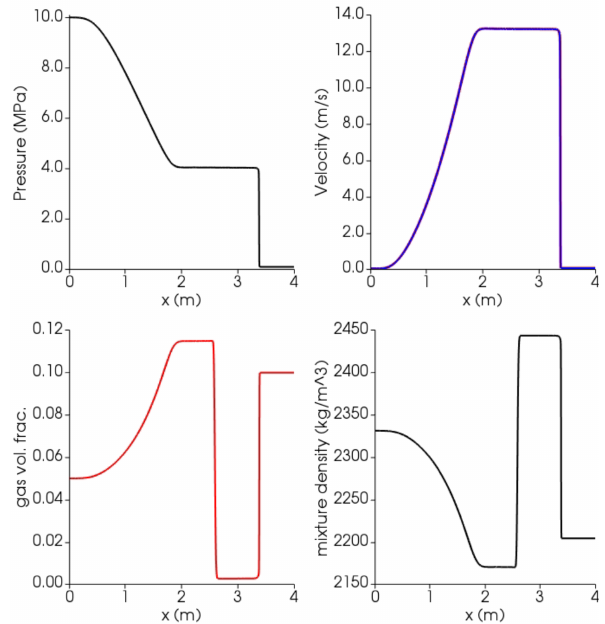
Figure 11. Results at time t = 0 . 001s for the axisymmetric Figure 10. Results at time t = 0 . 0065s for the axisymmetric gas gas water–basalt shock tube using the Lange–Carmichael EOS water–basalt shock tube using the Lange–Carmichael EOS (Lange (Lange and Carmichael, 1987) and the viscosity model of Gior- and Carmichael, 1987) and the viscosity model of Giordano et al. dano et al. (2008), with liquid phase switching from continu- (2008). Blue lines: liquid (basalt); red lines: gas (water). At time ous to dispersed. Blue lines: liquid (basalt); red lines: gas (wa- 0, the interface dividing the high-pressure (left, l) from low- ter). At time 0, the interface dividing the high-pressure (left, l) pressure (right, r) zone is placed at 2.5m. Initial conditions: P l = from low-pressure (right, r) zone is placed at 2.5m. Initial condi- 10MPa, P r = 0 . 1MPa, and T l = T r = 1273K for both phases; gas tions: P l = 10MPa, P r = 0 . 1MPa, and T l = T r = 1273K for both volume fraction: α l = 0 . 05, α r = 0 . 1, and U l = U r = 0 for both phases; gas volume fraction: α l = 0 . 05, α r = 1, and U l = U r = 0 for phases. Isobaric specific heat capacities in the gas and liquid both phases. Isobaric specific heat capacities in the gas and liquid = 2510Jkg − 1 K − 1 (https://webbook.nist.gov/, last phase are C P = 2510Jkg − 1 K − 1 (https://webbook.nist.gov/, last phase are C P g g = 2278Jkg − 1 K − 1 and access: 27 April 2022) as well as C P = 2278Jkg − 1 K − 1 and access: 27 April 2022) as well as C P l , H2O l , H2O = 1600Jkg − 1 K − 1 , respectively (Lesher and Spera, 2015). C P = 1600Jkg − 1 K − 1 , respectively (Lesher and Spera, 2015). C P l , basalt l , basalt Thermal conductivity of the liquid is 1.5WK − 1 m − 1 (Lesher and Thermal conductivity of the liquid is 1 . 5WK − 1 m − 1 (Lesher and Spera, 2015); for the water gas phase a Prandtl number of 0.9 is Spera, 2015); for the water gas phase a Prandtl number of 0.9 is used, corresponding to a thermal conductivity of 0.14WK − 1 m − 1 used, corresponding to thermal conductivity of 0 . 14 W K − 1 m − 1 (https://webbook.nist.gov/, last access: 27 April 2022). (https://webbook.nist.gov/, last access: 27 April